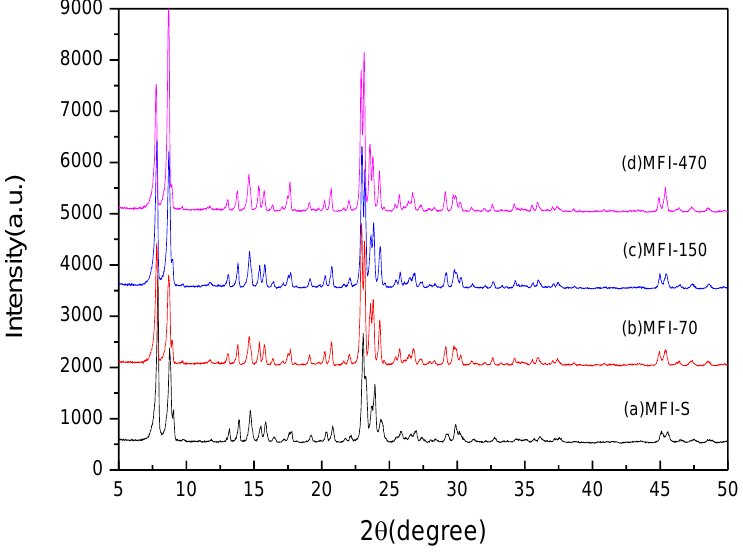
Figure 2. XRD patterns of ( a ) MFI-S ( b ) MFI-70 ( c ) MFI-150 and ( d ) MFI-470.